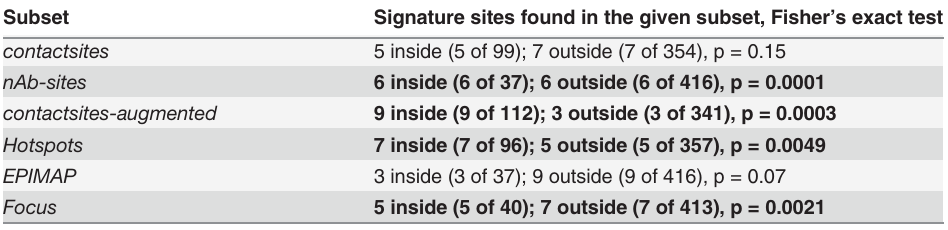
For each of the six pre-speci fi ed site sets, we compared the number of the 12 vaccine